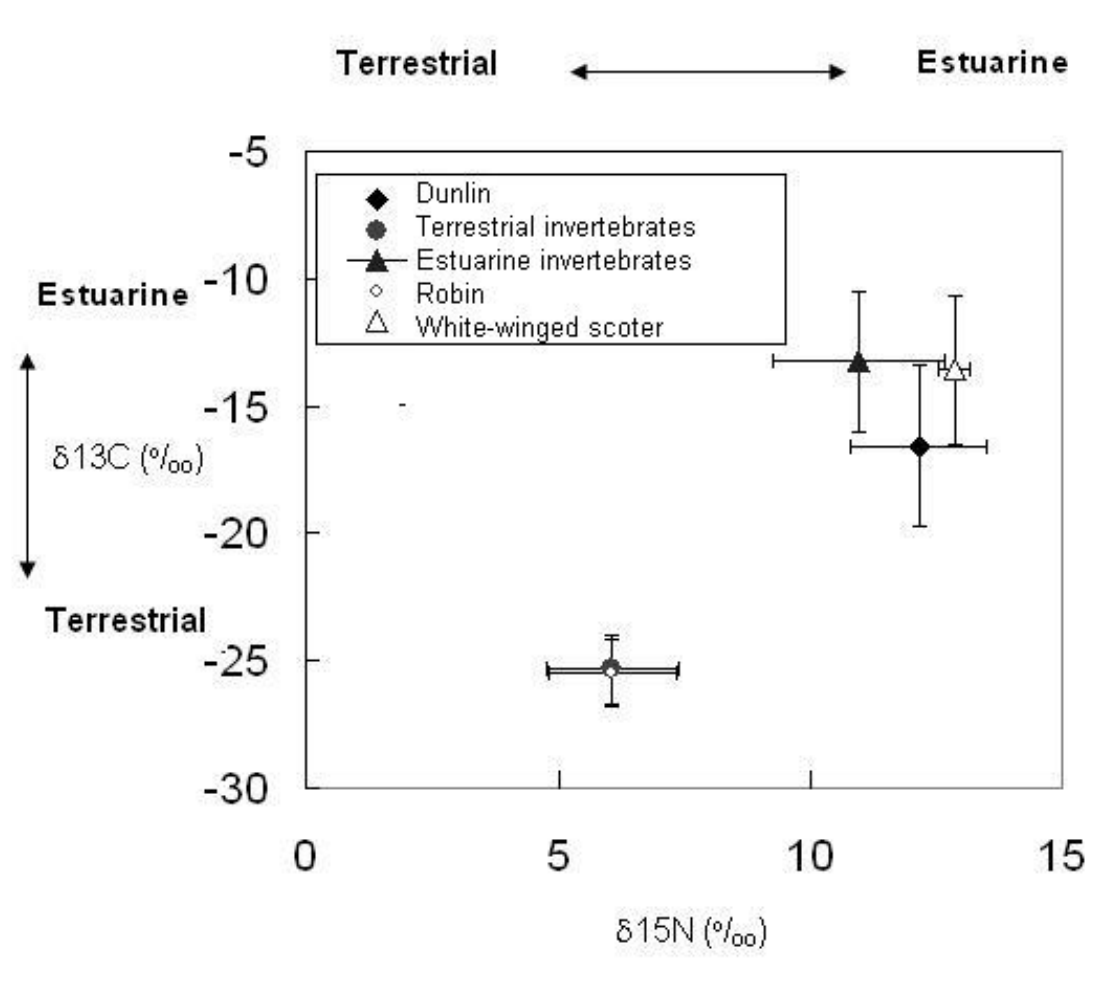
Fig. 2 . Isotopic values (mean ± SD d 15 N and d 13 C) for Dunlin whole blood (all years combined, n = 268), estuarine invertebrates ( n = 21 samples), and terrestrial invertebrates ( n = 16 samples). End points illustrated here are raw values and are not corrected by known fractionation factors. Samples of scoter ( n = 5) and American robin ( n = 5) are muscle